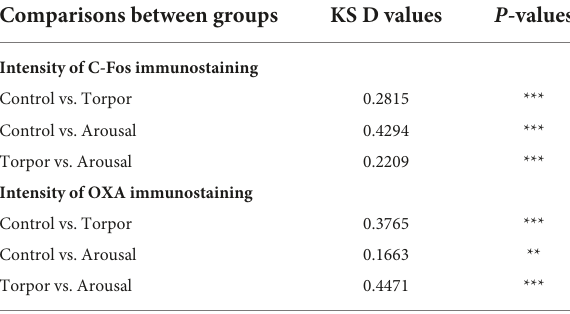
TABLE 4 Table showing D and p -values corresponding to the comparison between control, torpor, and arousal experimental groups of the frequency distribution of C-Fos (top) and OXA (bottom) immunostaining of orexinergic cells (Kolmogorov-Smirnov; GraphPad Prism software,